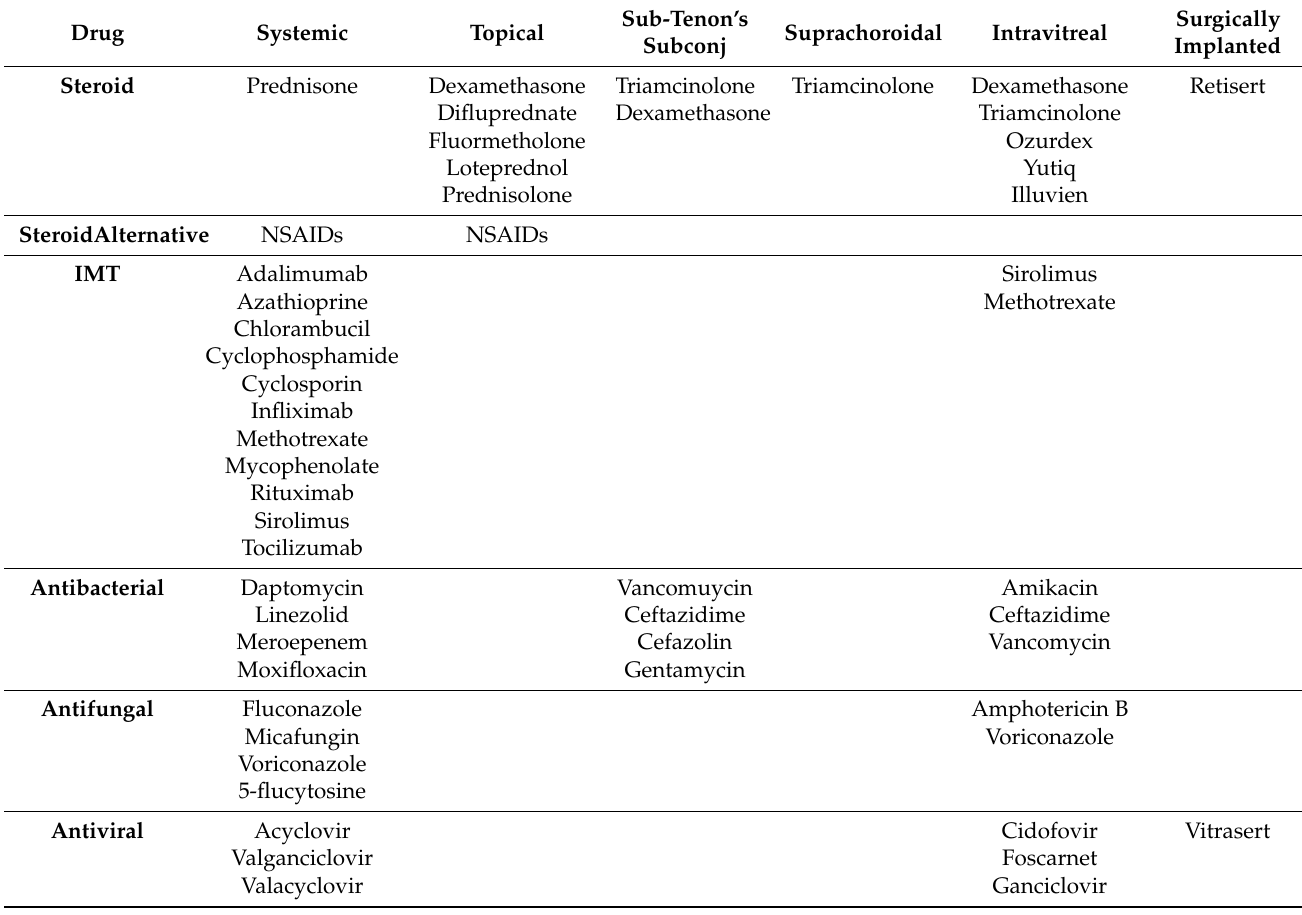
Table 2. Most commonly employed uveitis medications. IMT, immune modulatory therapy; NSAID, nonsteroidal anti- inflammatory drug; subconj,